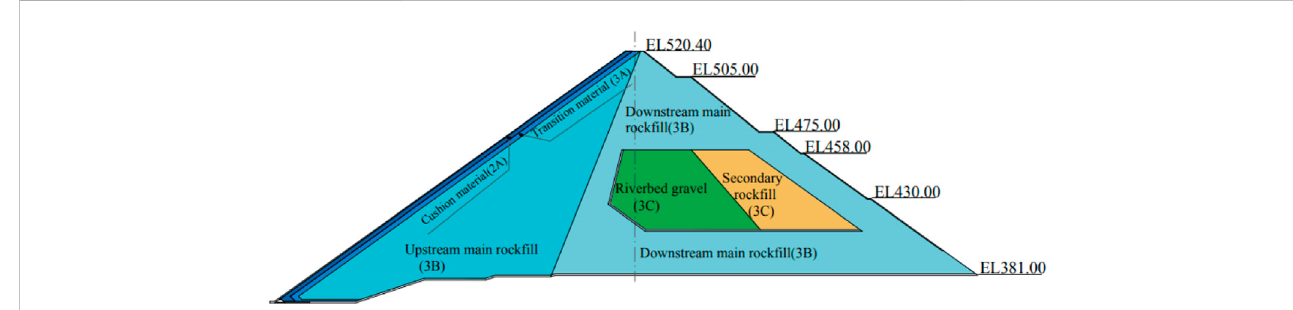
FIGURE 2 Dam material partition drawing.